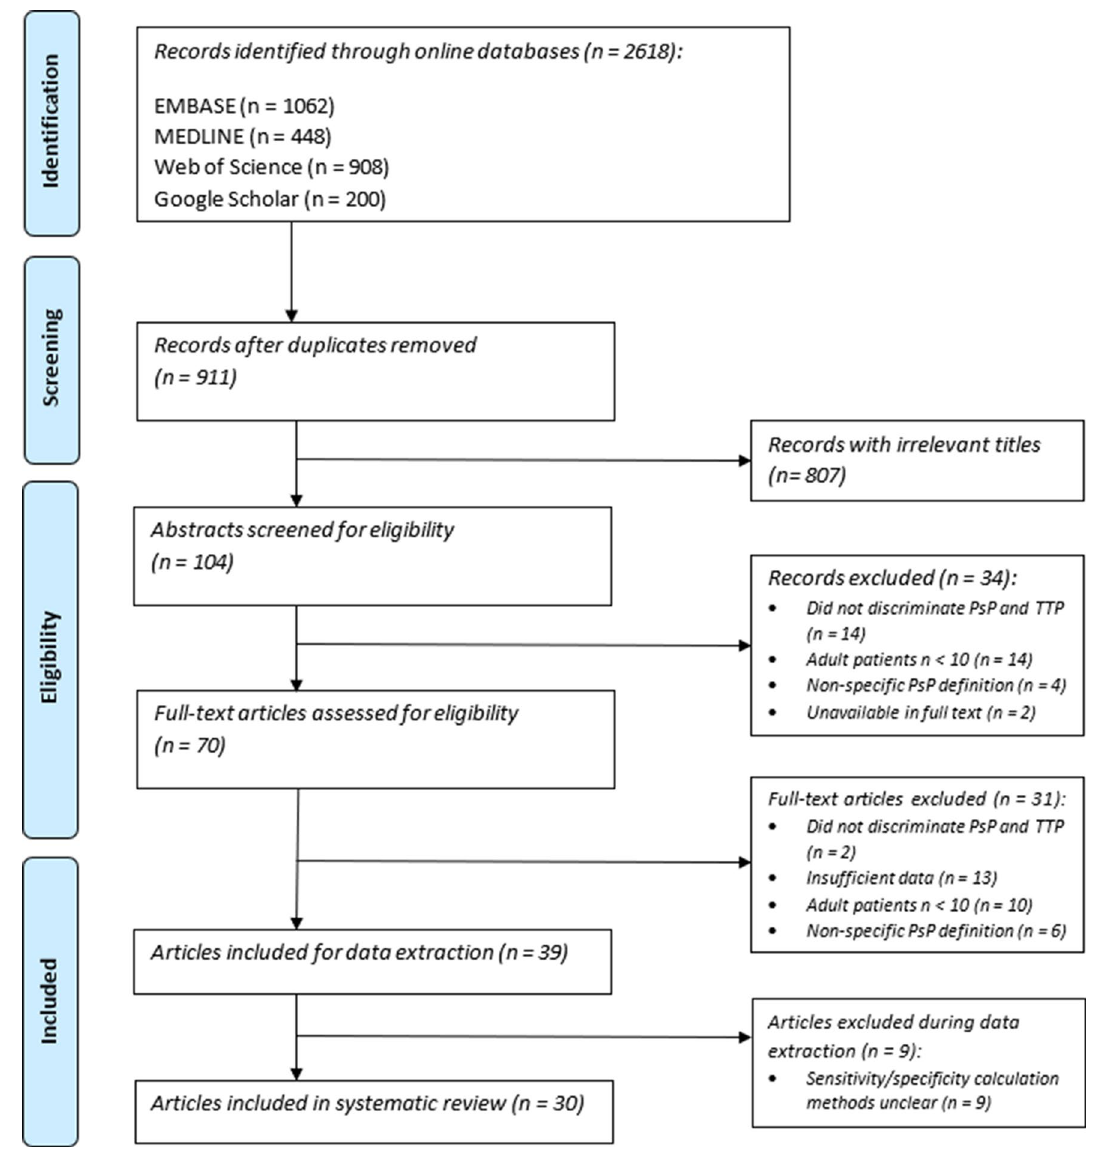
Figure 1. PRISMA flow chart of the study selection process. sP = pseudoprogression; TTP = true tumour